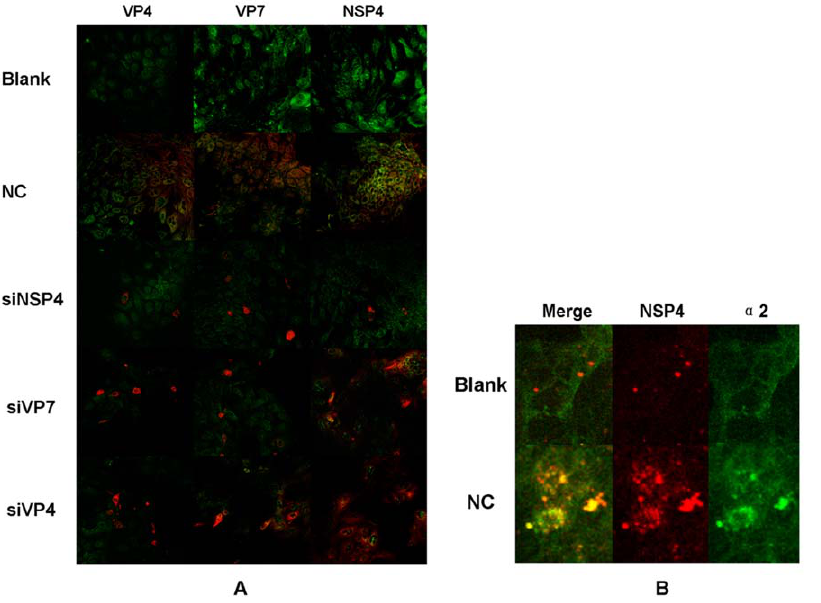
Figure 2. Immunofluorescence for rotavirus proteins and integrin a 2. (A) All viral proteins were expressed in the cytoplasm of cultured extrahepatic biliary epithelia (EHBE). Decreased viral protein expression and less infected cells were evident in siNSP4 transfected EHBE. siVP7 transfection significantly reduced VP4 and VP7 expression while leaving NSP4 expression unchanged. siVP4 inhibited the expression of VP4, but the expression of the other 2 proteins was not influenced. Magnification, 6 200. (B) NSP4 positive biliary epithelia had higher expression of integrin a 2 compared to non-infected cells. Magnification, 6 1000. doi:10.1371/journal.pone.0023655.g002 PLoS ONE |